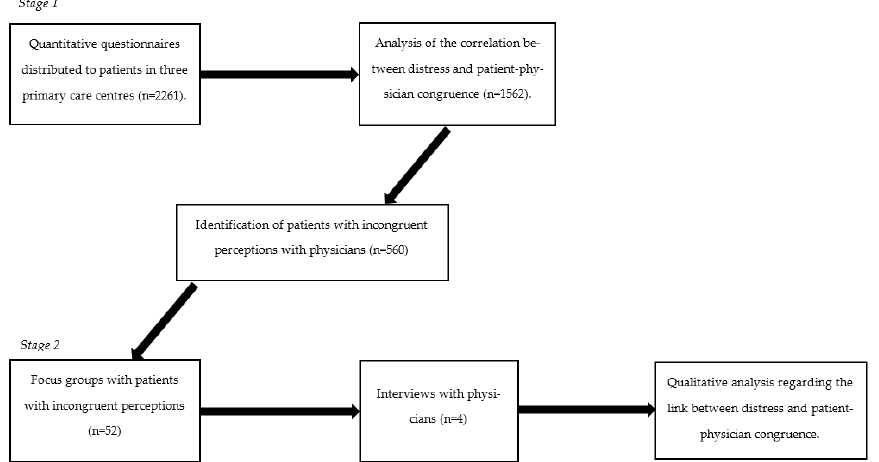
Figure 1. Flow diagram of the mixed methods research